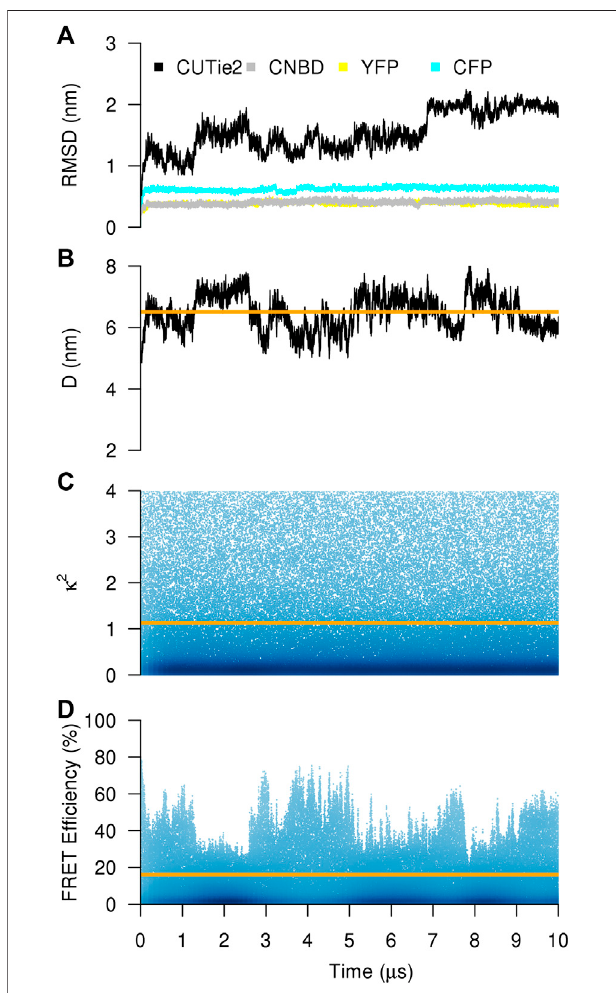
FIGURE 2 | CG simulation of the CUTie2 sensor. (A) Instantaneous RMSD of one randomly chosen conformer in cGMP-bound conformation. Black, gray, yellow, and cyan correspond to the whole molecule, the CNBD, the YFP, and the CFP modules, respectively. (B – D) Distance between chromophores, κ 2 , and FRET ef fi ciency. The orange line in each panel corresponds to the average over the entire trajectory.